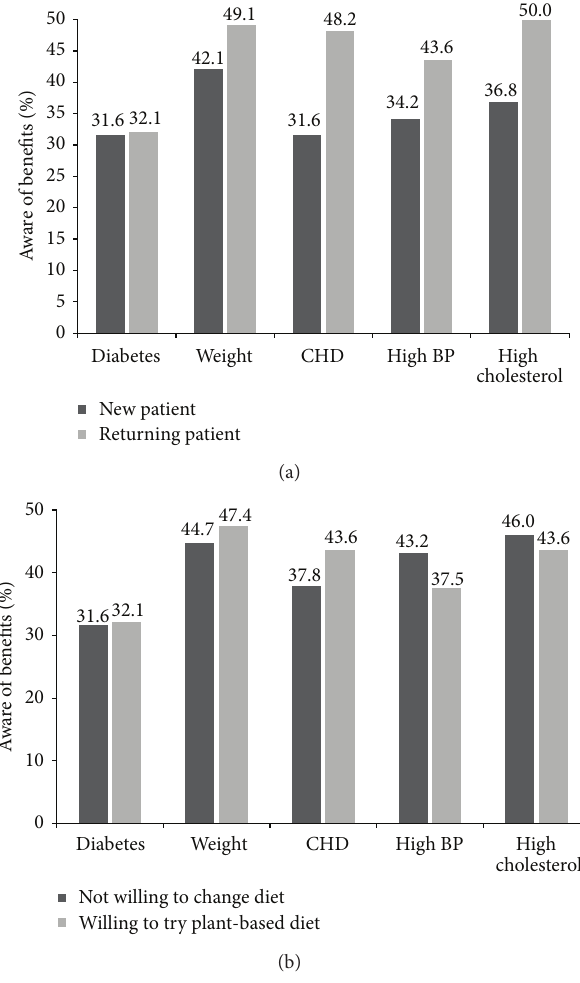
Figure 1: Percentage of patients who are aware of the benefits of a plant-based diet on various chronic conditions. Chi-square analysis comparing willingness to change diet and status of patient, all